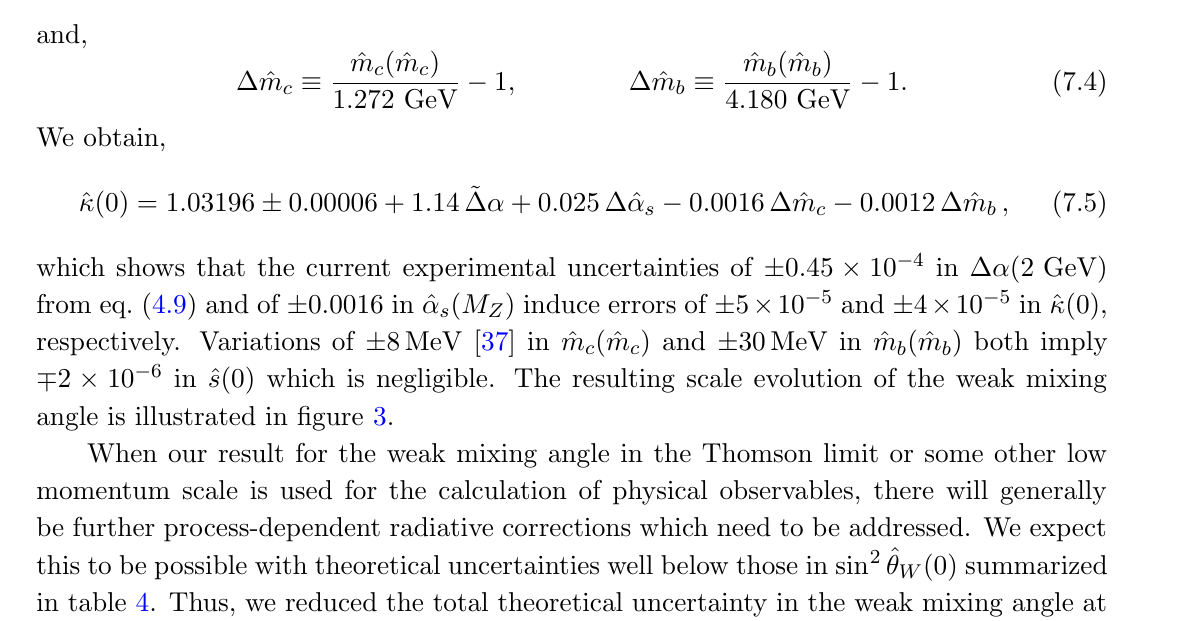
Figure 3 . Scale dependence of the weak mixing angle in the MS renormalization scheme. The dots indicate the scales where a particle is integrated out. The total uncertainty corresponds to the thickness of the line. The (cid:12) -function of SU(2) L changes sign at (cid:22) = M W , where the fermionic screening e(cid:11)ects of the e(cid:11)ectively Abelian gauge theory are being overcompensated by the anti- screening e(cid:11)ects of the full non-Abelian electroweak